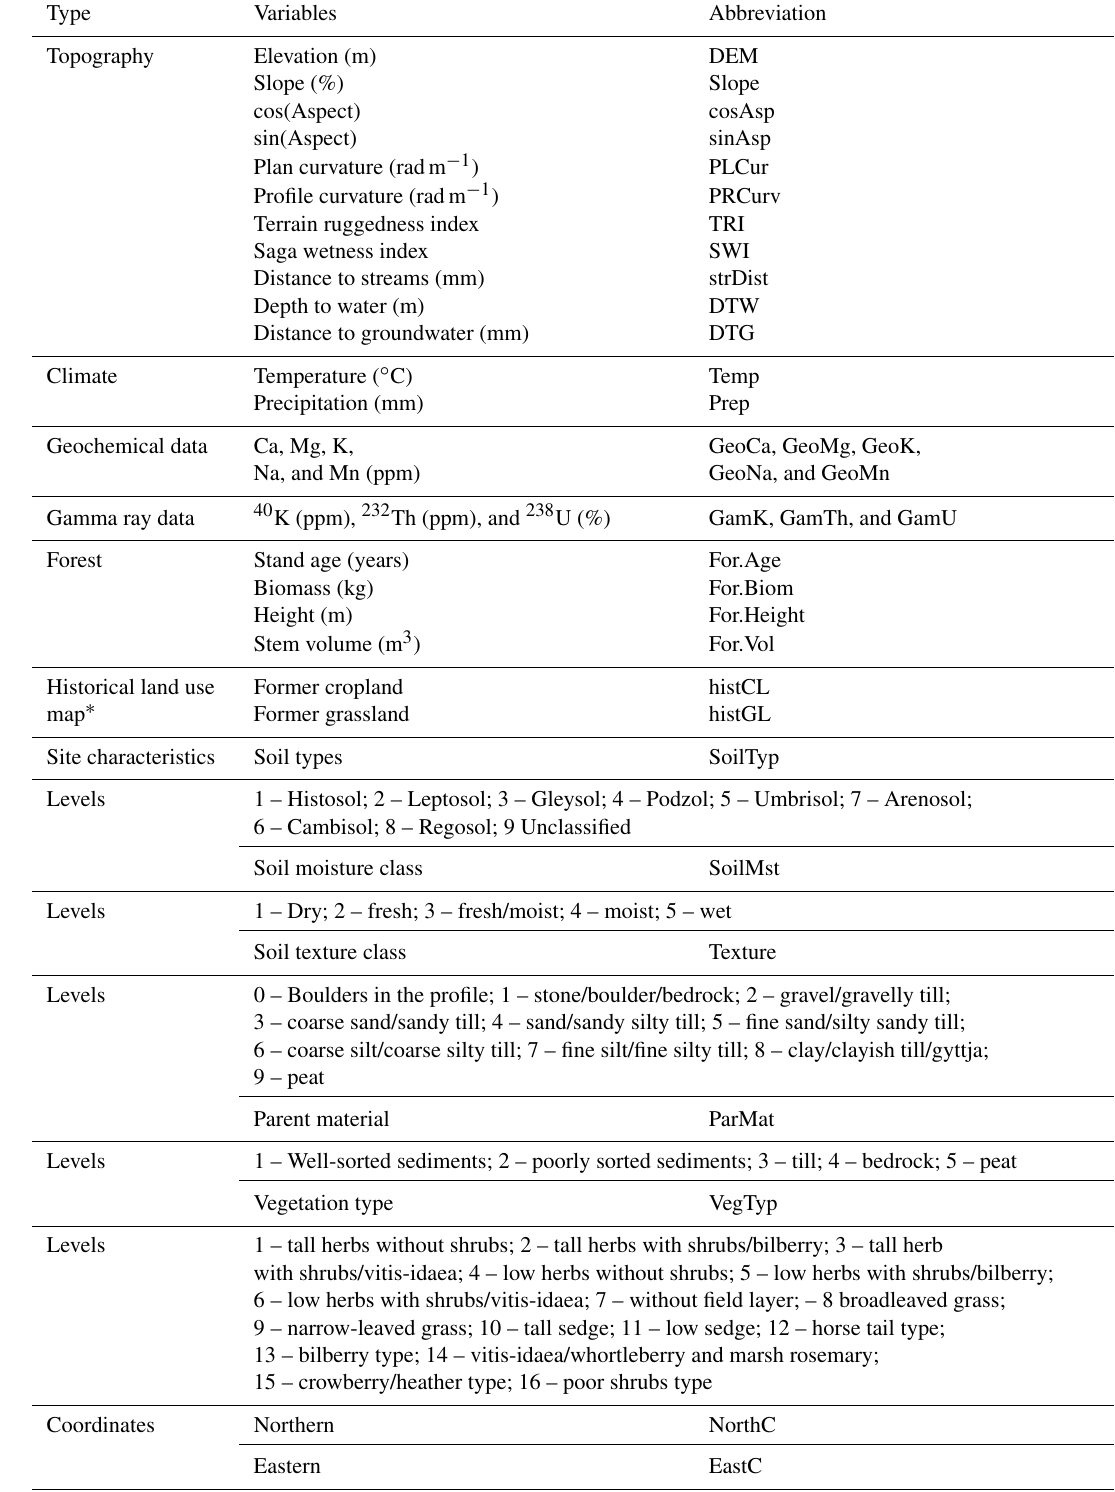
Table 1. List of explanatory covariates for predicting SOC